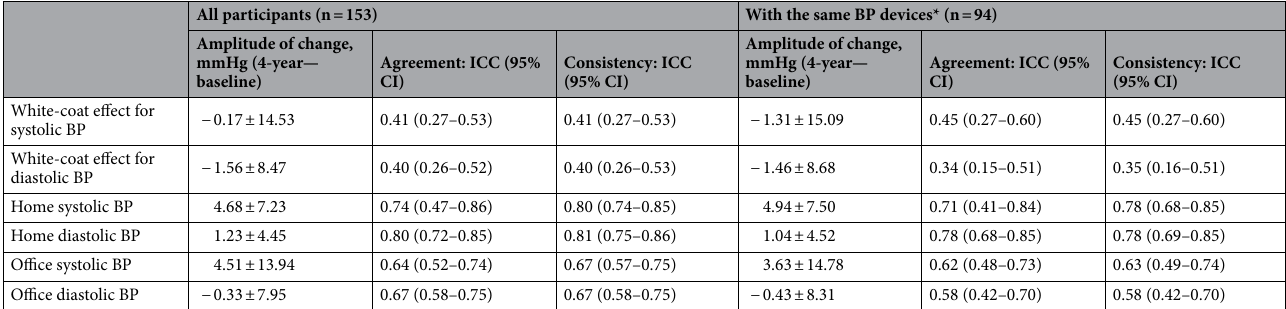
Change in the white-coat effect for systolic BP (the 4-year visit − baseline), mmHg